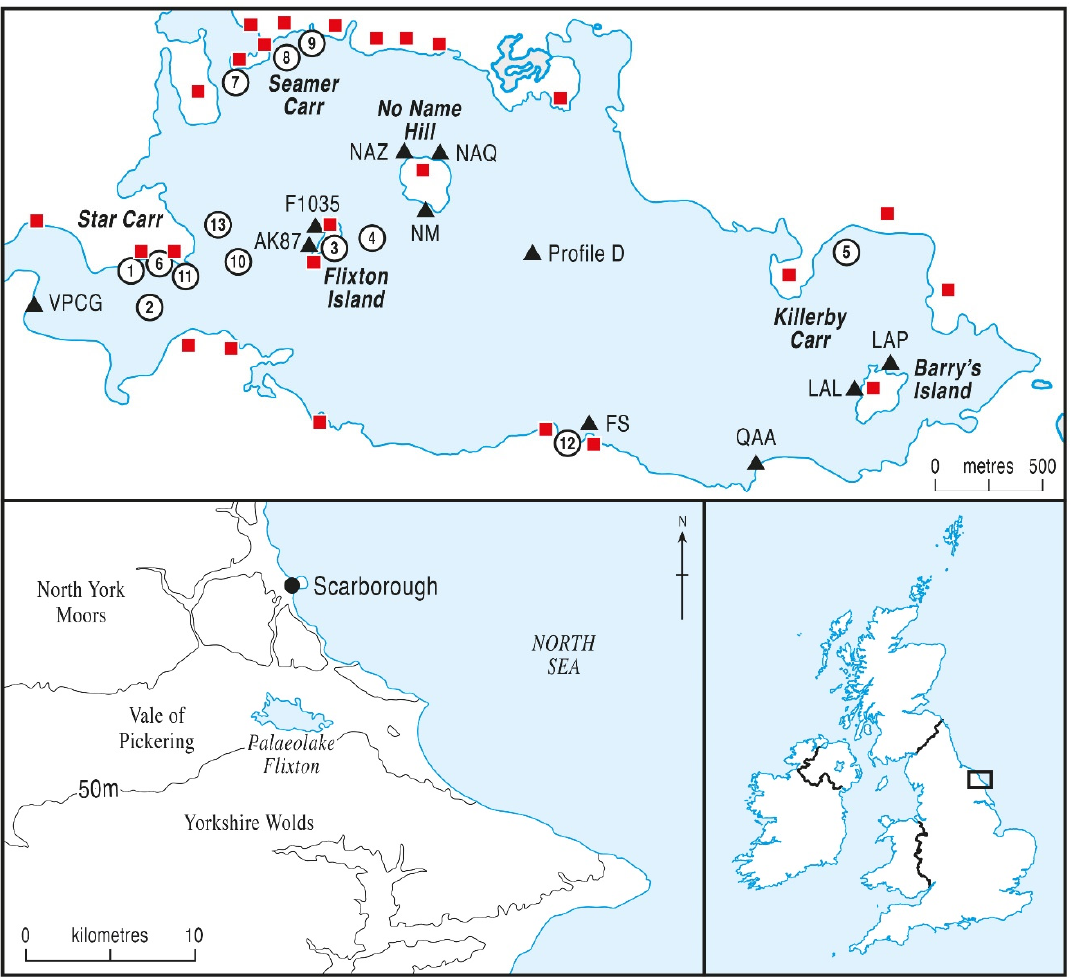
Figure 1. Location of palynological sites at Palaeolake Flixton in northeast Yorkshire, UK. Solid triangles are the new sites presented in this paper. Numbered sites are previously published diagrams: 1. Star Carr, 2. Flixton A16, 3. Flixton DB1, 4. Flixton1, Flixton 2 and Flixton KH, 5. Killerby Carr [10]